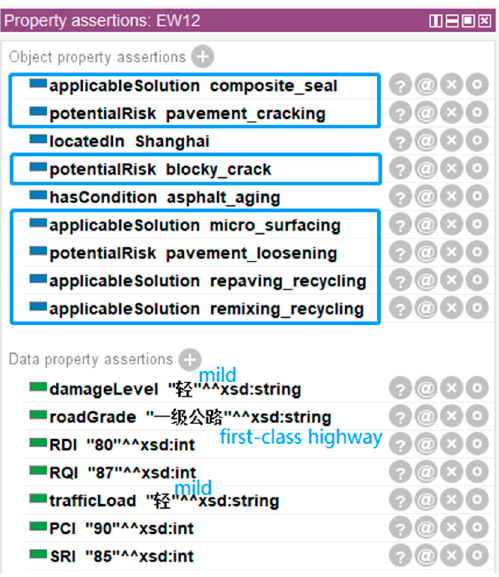
Figure 7. Result of expressway renewal based on the knowledge graph.